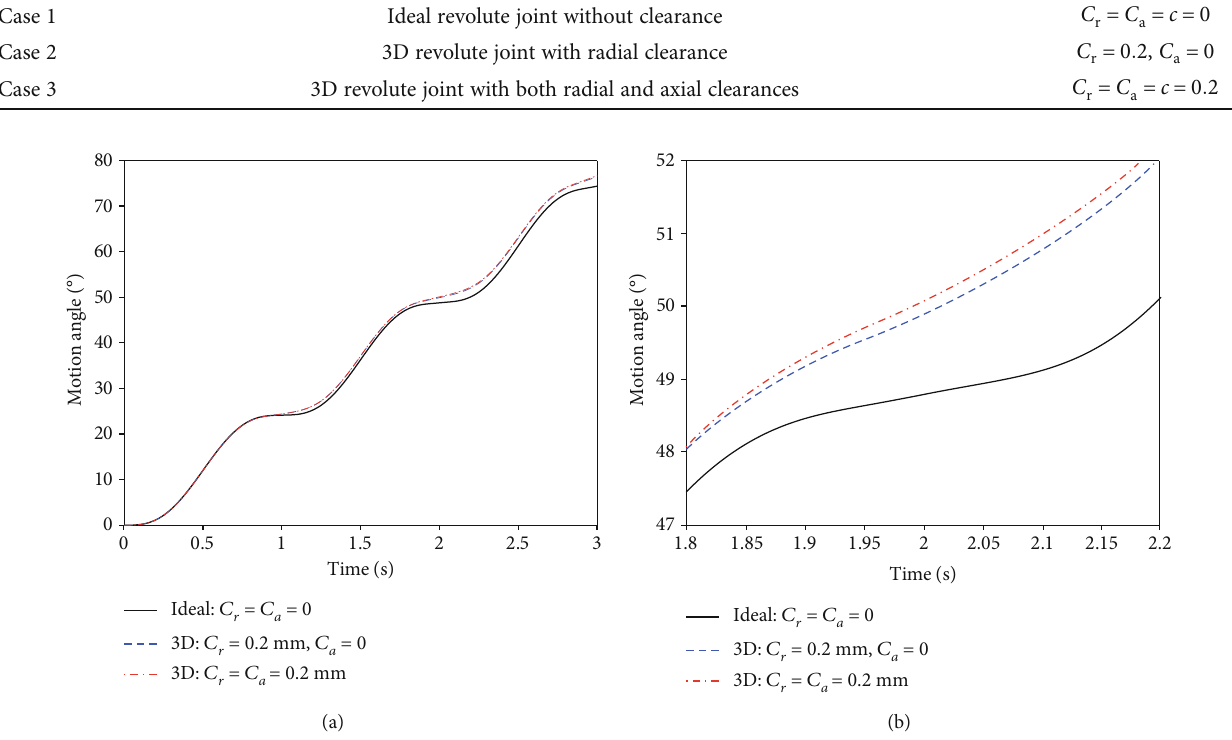
Figure 7: Motion angular displacement of the antenna: (a) motion angle; (b) partial